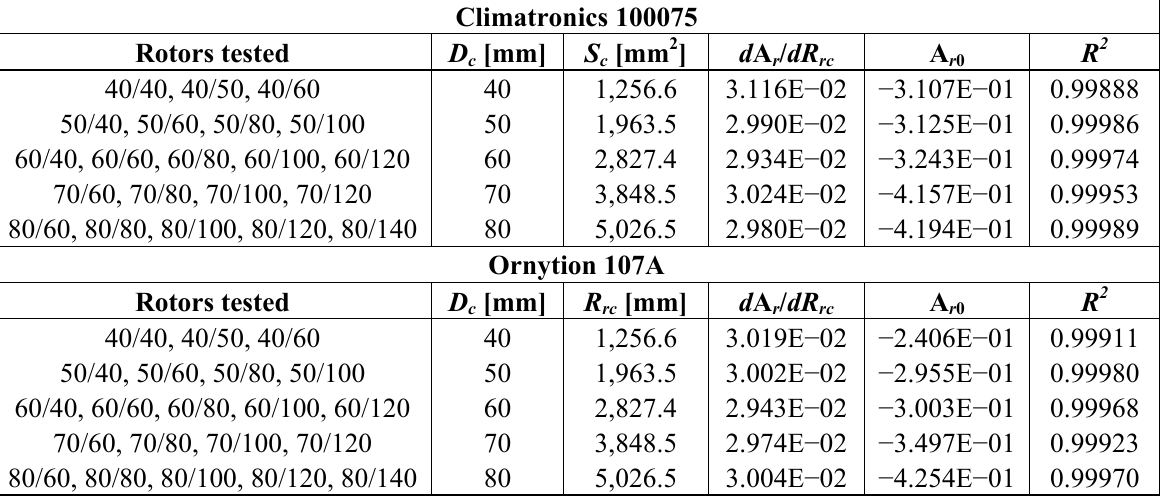
, as a function of the cups’ center rotation radius, R r